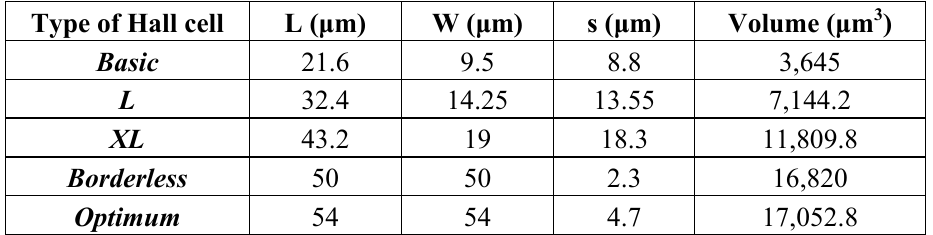
Table 1. Geometrical parameters of the simulated Hall devices.